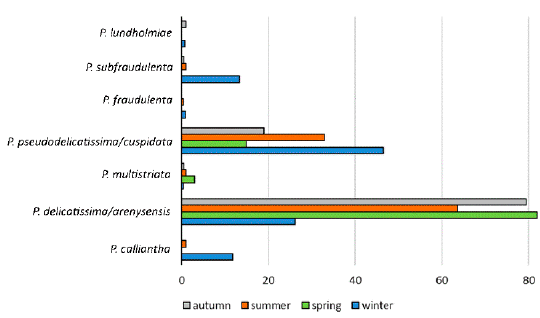
ff erent seasons, analysed by